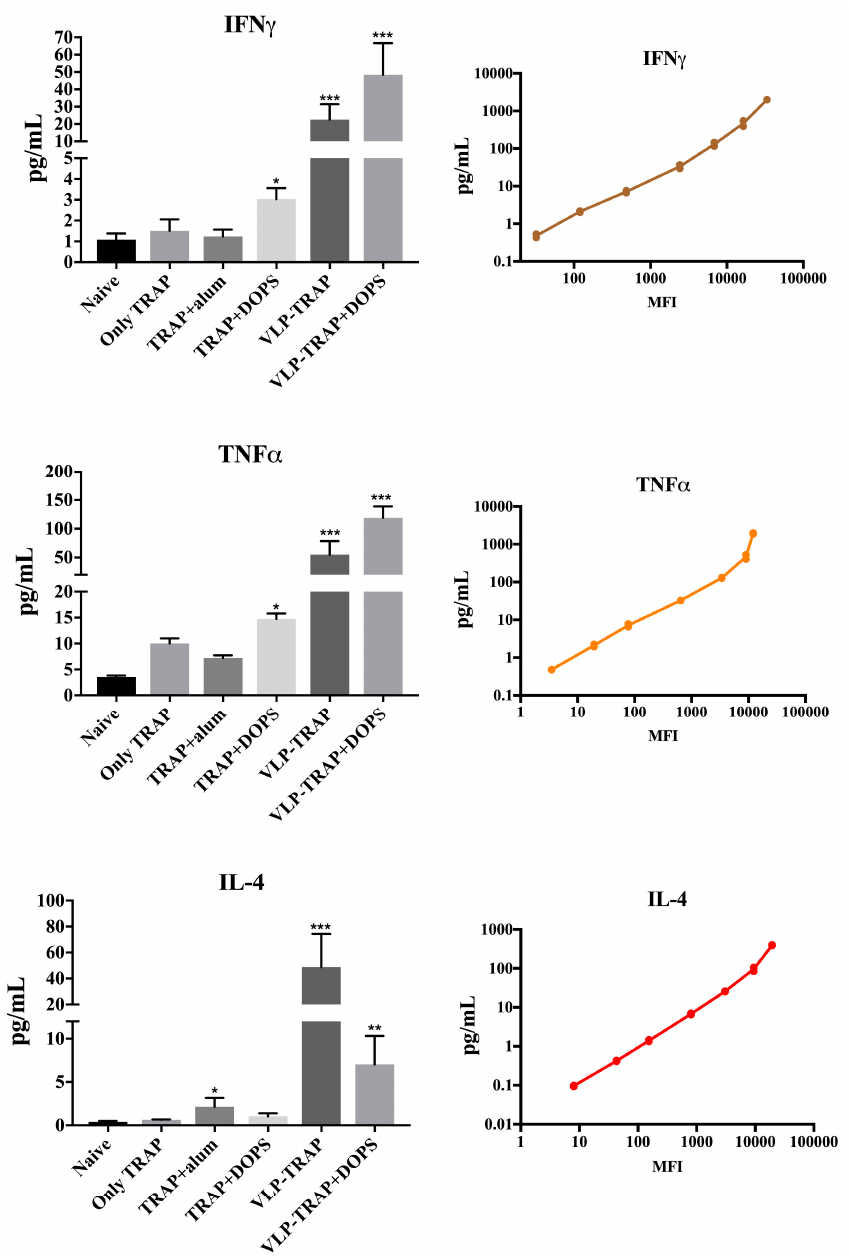
Figure 1. Assessment of CD4 + T cells polarization. Mice were immunized once every three weeks. One week after the third vaccination the mice were bled to obtain sera for cytokine analysis. To evaluate cytokine production, TNF α , IFN γ (Th1 and CTL), and IL-4 (Th2) were measured by multiplex assays MHSTCMAG-70K kit. Also, for experimental control, standard curves were made of each cytokine and compared with the expected concentration provided by the kit, as seen in the figure. The results were analyzed using GraphPad Prism software applied to assess the means of the groups by unpaired t-tests. Note: *** p -value < 0.0001; ** p -value < 0.001; * p -value < 0.01. MFI = Median Fluorescence Intensity.